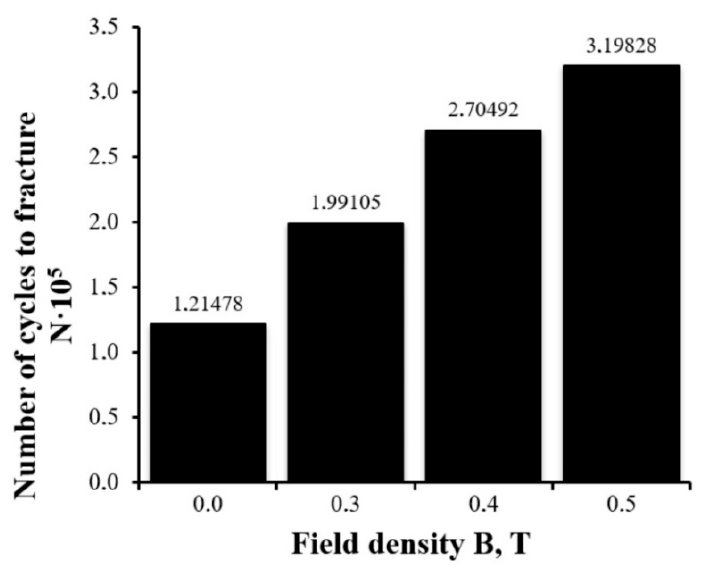
Figure 3. Dependence of the average number of cycles to fracture N upon the value of the field density B under the cyclic fatigue life tests of commercially pure titanium VT1-0.